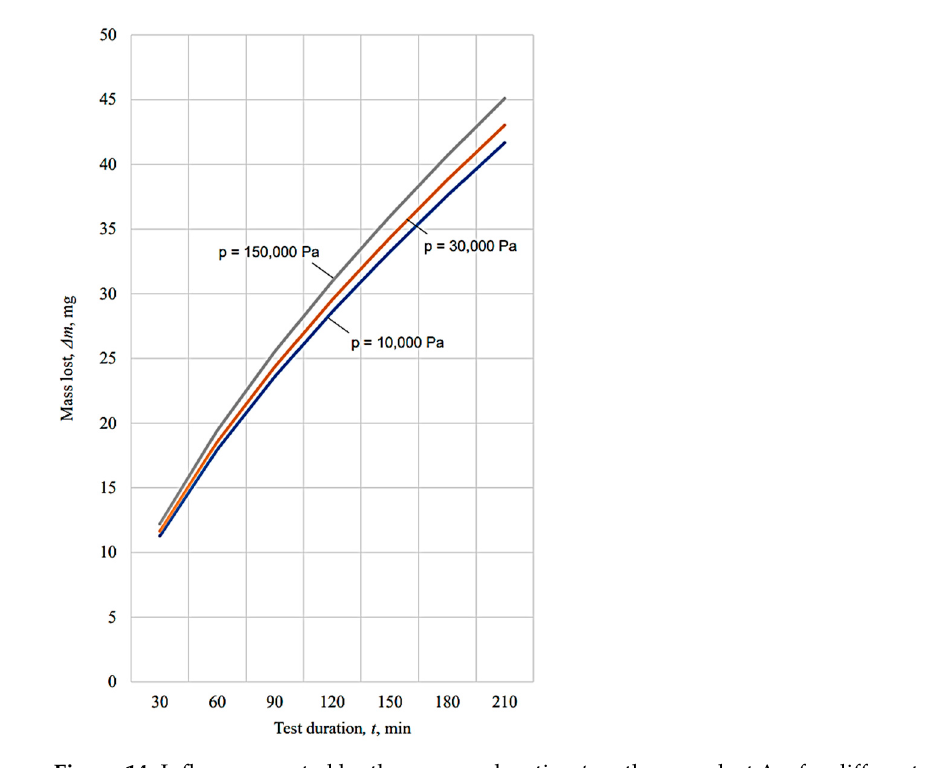
Figure 13. The influence exerted by the pressure on the mass lost Δ m for different durations of the process applied to the tested surface in the case of the vibroburnishing process.